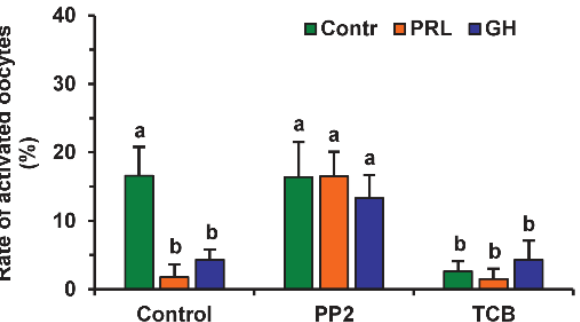
Figure 2. Effects of PRL (50 ng/mL) and GH (10 ng/mL) on spontaneous parthenogenetic activation during the 44 h aging of bovine DOs in the presence and in the absence of PP2 (20 µ M), the inhibitor of Src-family tyrosine kinases, and triciribine (TCB, 50 µ M), the inhibitor of Akt kinase. Data derived from 4 independent replicates (a total of 79–86 oocytes per each treatment group) are expressed as means ± SEM. Different letters indicate significant differences between means (at least p < 0.05).